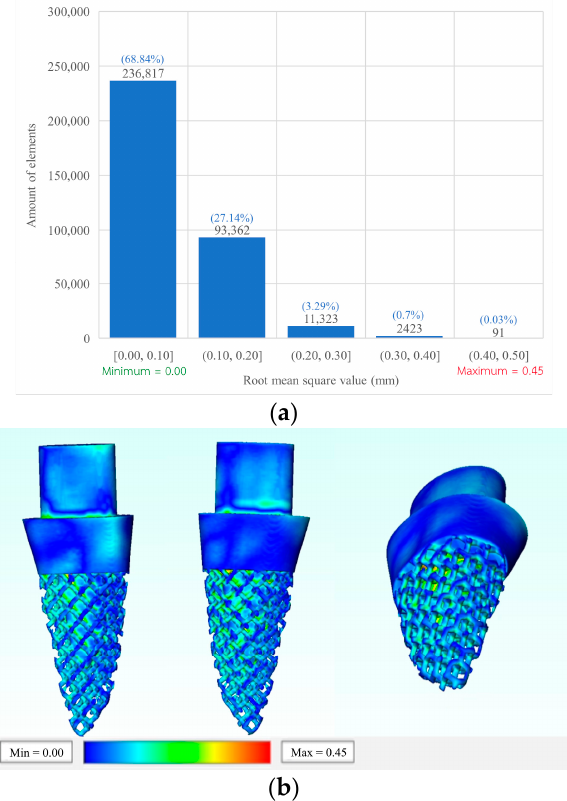
Figure 6. Root mean square value of the implant model ( a ) bar chart of elements represent in root mean square value; ( b ) 3D model of root mean square.